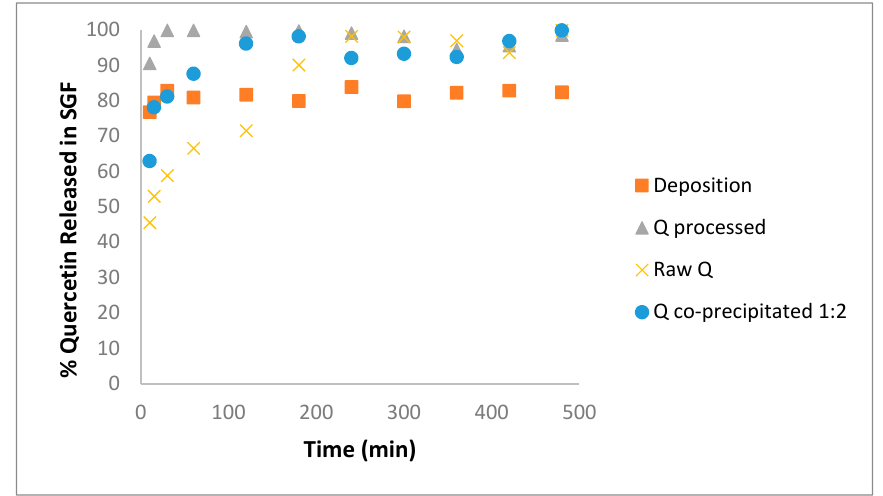
Figure 7. Release test of Q from composites in SGF corresponding to experiment 8 (180 bar, 323 K, 30 g/min CO 2 flow rate, SAS2).